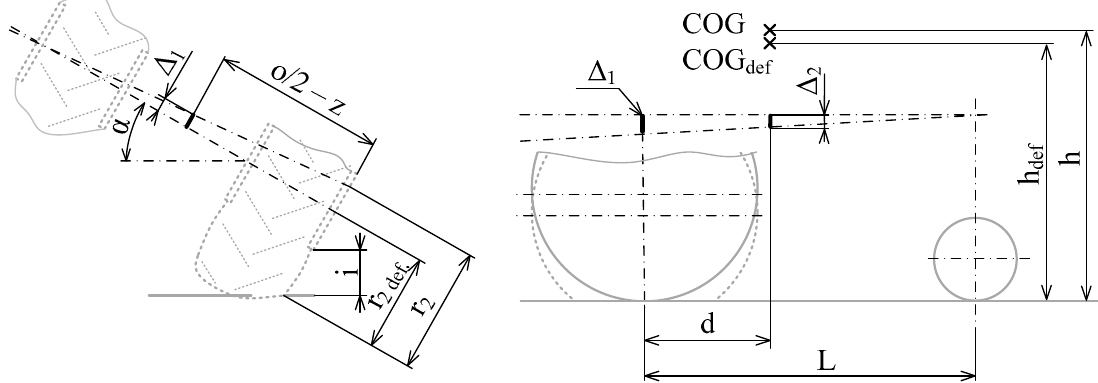
Figure 5. Determination of vertical shift of centre of gravity due to vertical tyre deformation.